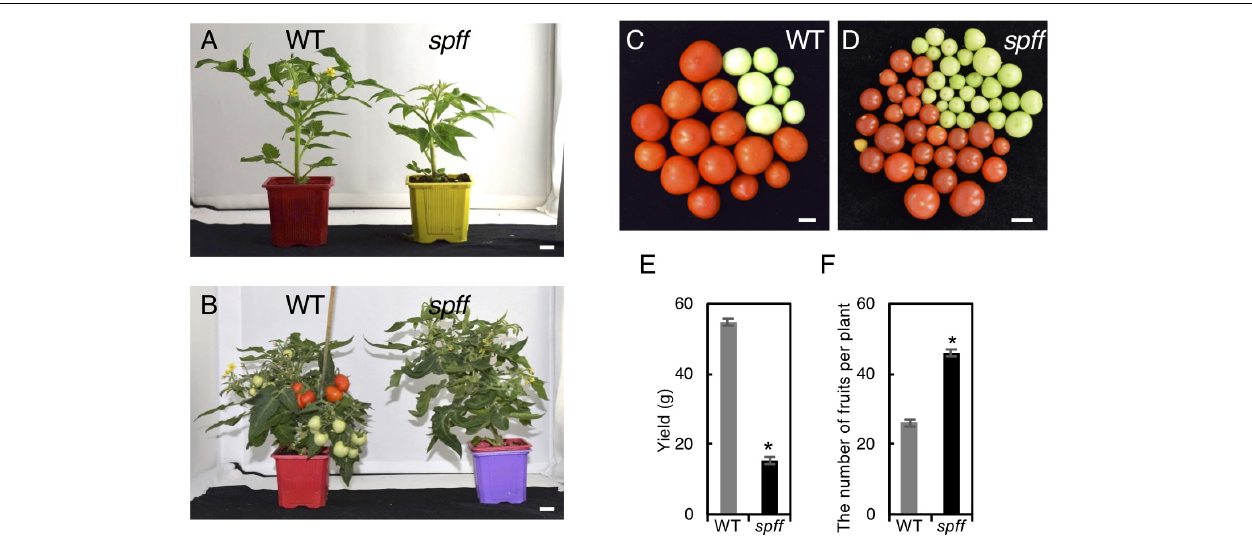
FIGURE 5 | Fruit phenotypes and yield evaluation of the spff mutant. (A) Plant appearance of WT (left) and spff (right) mutant at 40 days and (B) 66 days after seed germination. The spff grew slowly than WT. Bars are 1 cm. Representative harvested fruit in WT (C) and spff mutant (D) after 112 and 173 days of seed germination, respectively, and their yield of mature red fruits (E) . (F) The number of total fruit produced in WT and spff mutant after 112 and 173 days of seed germination, respectively. At least three biological repetitions were performed and their mean values with SE are shown. Asterisks indicate significant difference between WT and spff mutant (Student t test, p < 0.01).